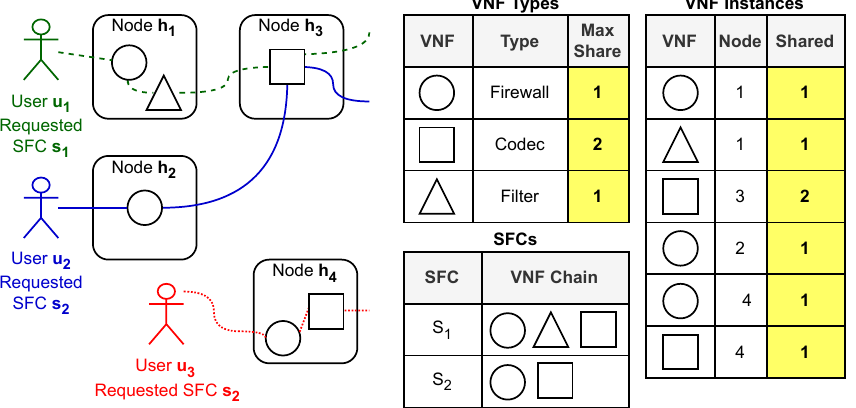
Figure 2. VNF sharing during phase 1 of the smart VNF placement